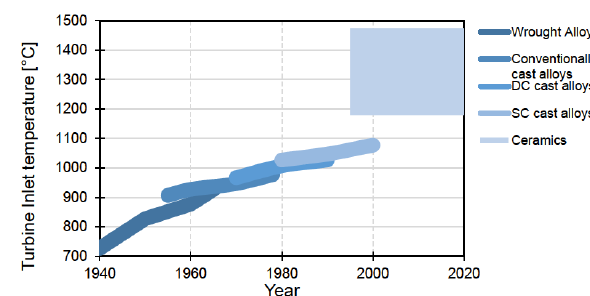
The relationship between the stress ( σ ) and mass is not as strong as between the rotational speed and stress.